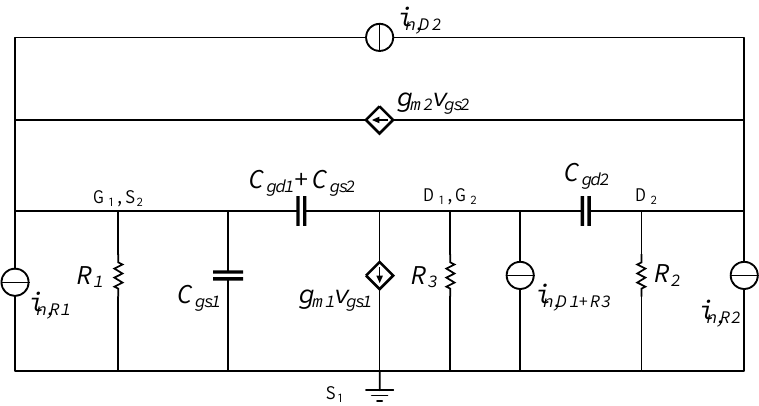
Figure 5. Simplified equivalent circuit of the RGC input stage used for noise analysis.